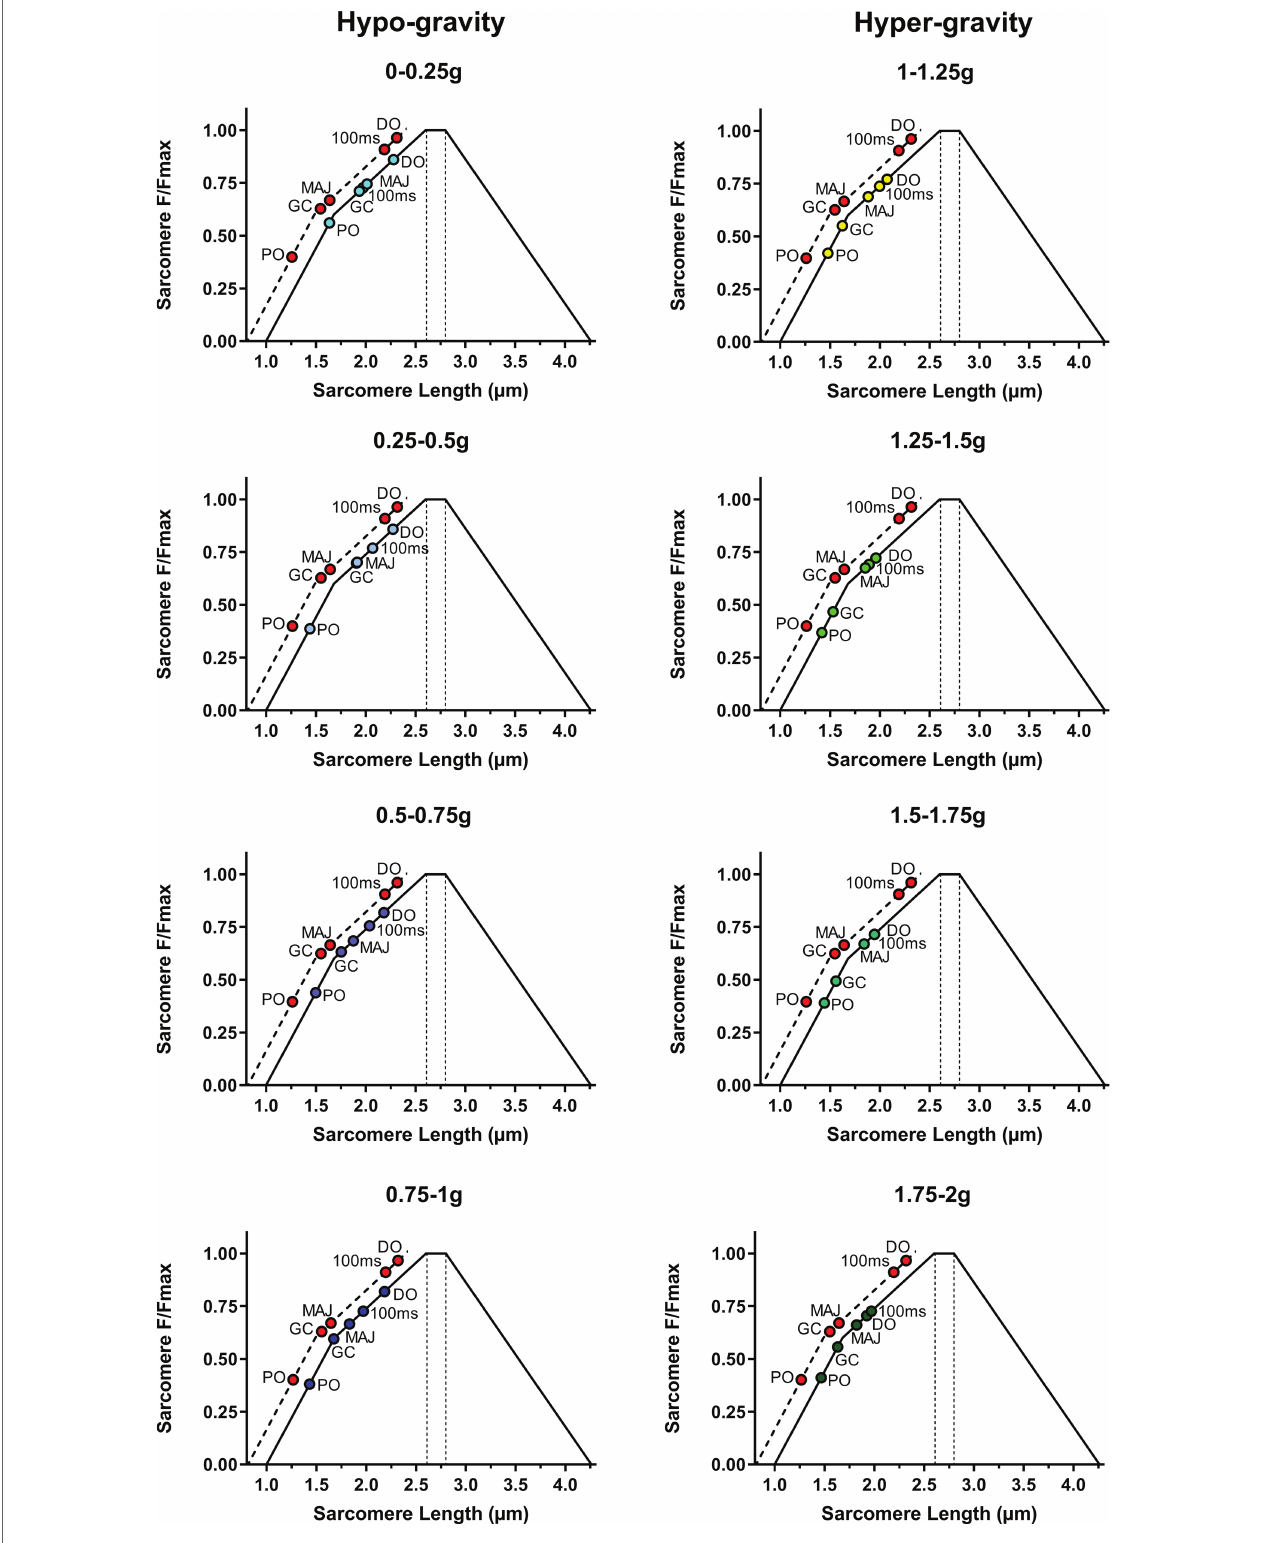
FIGURE 13 | Operating sarcomere length in its length-tension (L-T) relationship during the five different drop jump time points in hypo-gravity and hyper-gravity. A comparison with the same drop jump time points in 1 g is also shown (dashed line, red